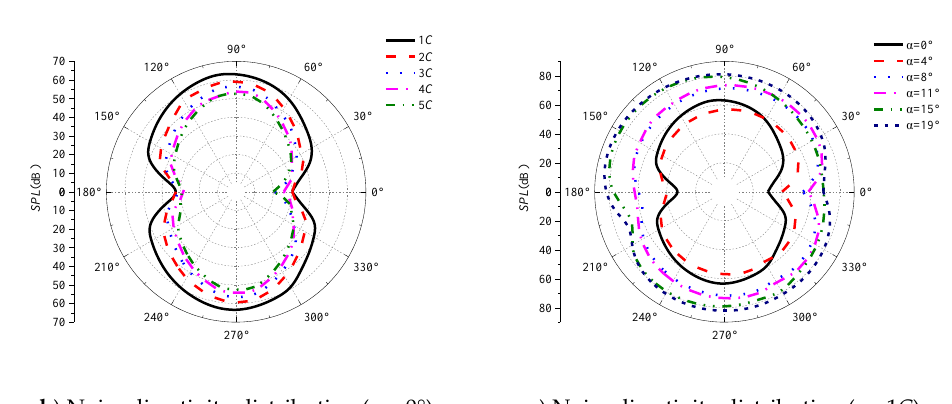
Figure 12. Noise directivity distribution of the airfoil without the NLPS.